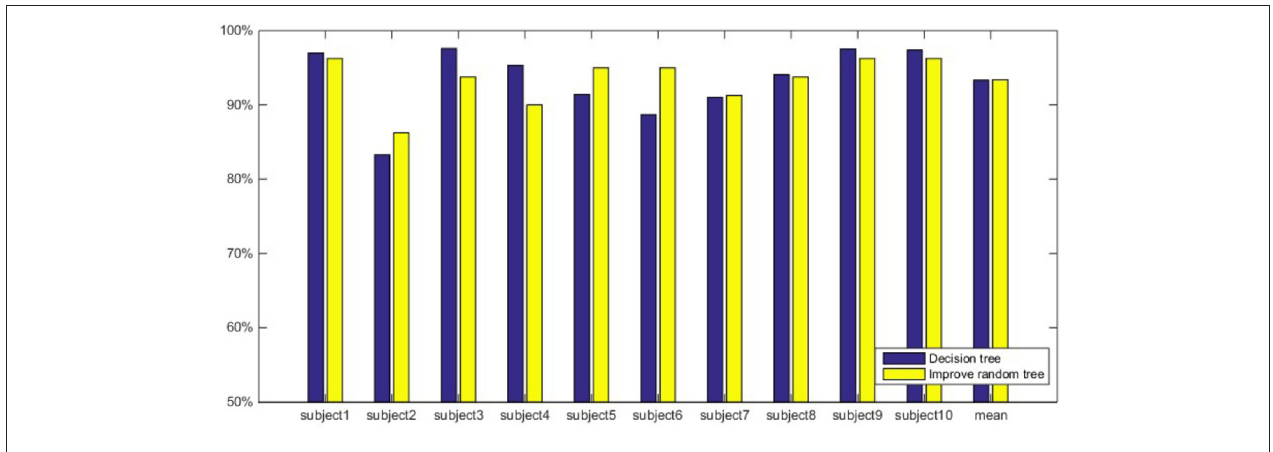
FIGURE 8 | Comparison of classification accuracy of two classifiers based on WpEn.